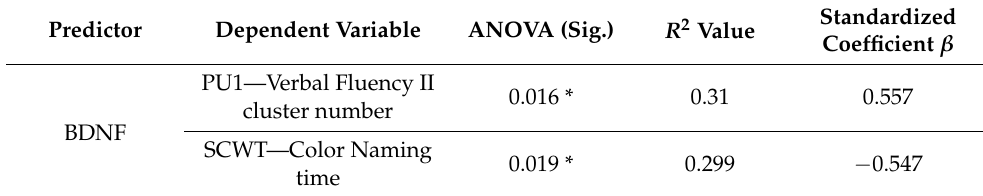
Table 1. Linear regression—first measurement, T0.